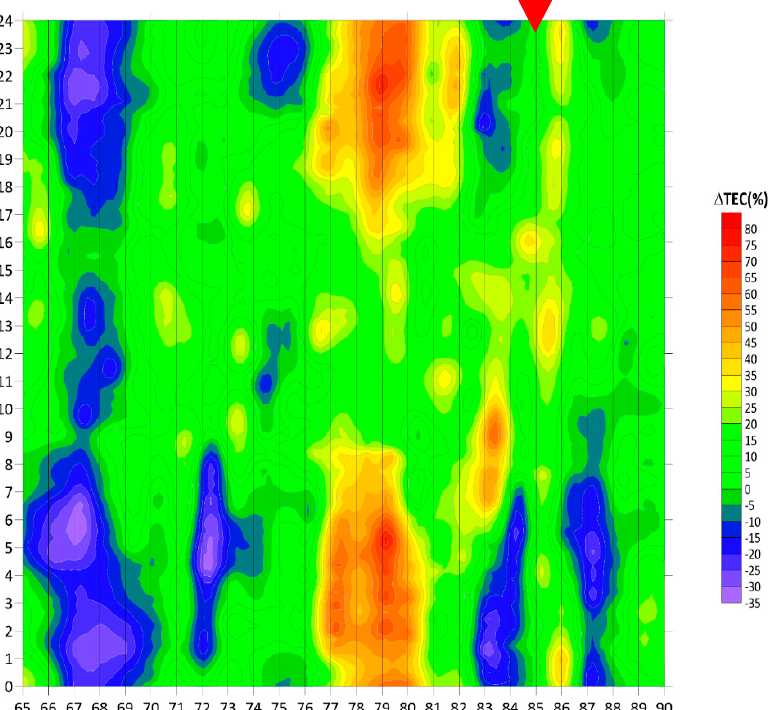
Figure 10. Ionospheric GPS TEC percentage residual variations for March 2020 (GPS receiver pets ). The moment of the M7.5 earthquake that occurred east of the Kuril Islands is indicated by the red triangle.